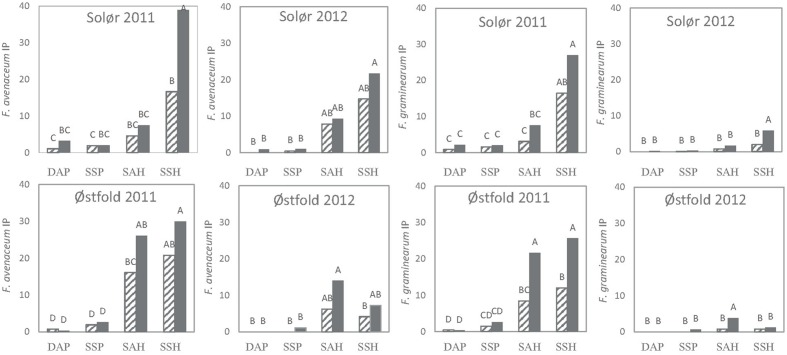
Effects of tillage treatment and residue regimes on the inoculum potential (IP) of F. graminearum and F. avenaceum in two experimental fields of oats in southeast Norway (Solør and Østfold) in 2011 and 2012. Tillage treatments include DAP, deep autumn plowing; SSP, shallow spring plowing; SAH, shallow autumn harrowing; SSH, shallow spring harrowing. Data from the two residue regimes examined are indicated by either hatched bars, where the straw was removed, or filled bars, where the straw was chopped and retained in the field. IP was calculated as the relative soil area covered with oat residues after sowing in spring (0–1) multiplied by the percentage of the residues infested with the respective Fusarium species. Different letters indicate significant treatments effects at p = 0.05.